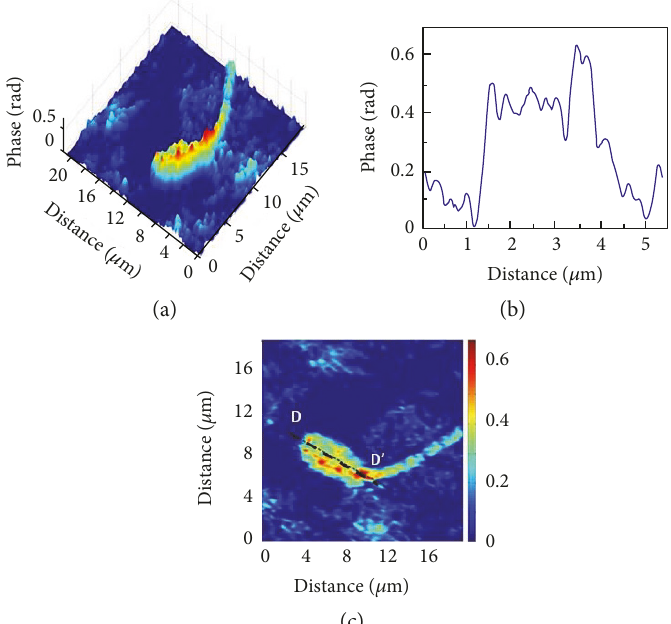
Figure 3: (a) Pseudo-3D representation of the phase map of the investigated spermatozoon obtained by digital holography microscopy. The arrow indicates the observed protuberance in the region connecting the tail to the head of the spermatozoon. (b) Phase intensity pro fi le of the spermatozoon along the line DD ′ stressed in (c)